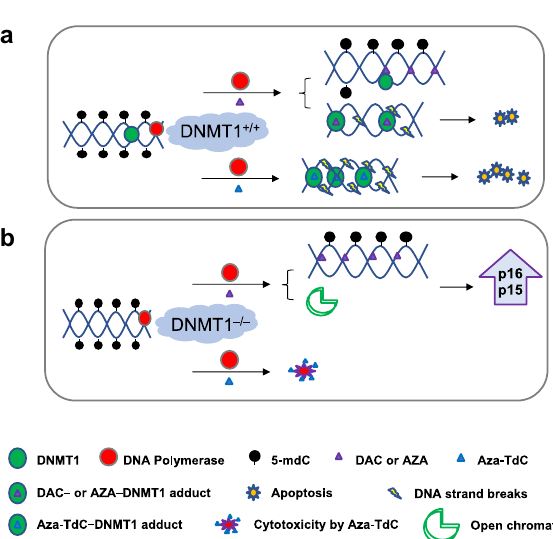
Figure 5. DNMT1 deletion, its protein consequence and differential expression profile in human colon cancer. ( a ) Oncoprint of DNMT1 genetic alterations (deep deletion and gene amplification) in 105 cases of colon cancers. ( b ) Heatmap of DNMT1 protein expression in 86 cases without DNMT1 deletion in relation to the 8 cases with DNMT1 gene deletion including deep and shallow. Each row represents one patient. * P = 0.017. ( c ) Protein consequence of the genes enriched in the DNMT1 deleted and undeleted groups shown in volcano plot. ( d ) Bar graph showing top enriched proteins in the deleted (blue bars) and undeleted (orange bars) groups; all q values < 0.05.